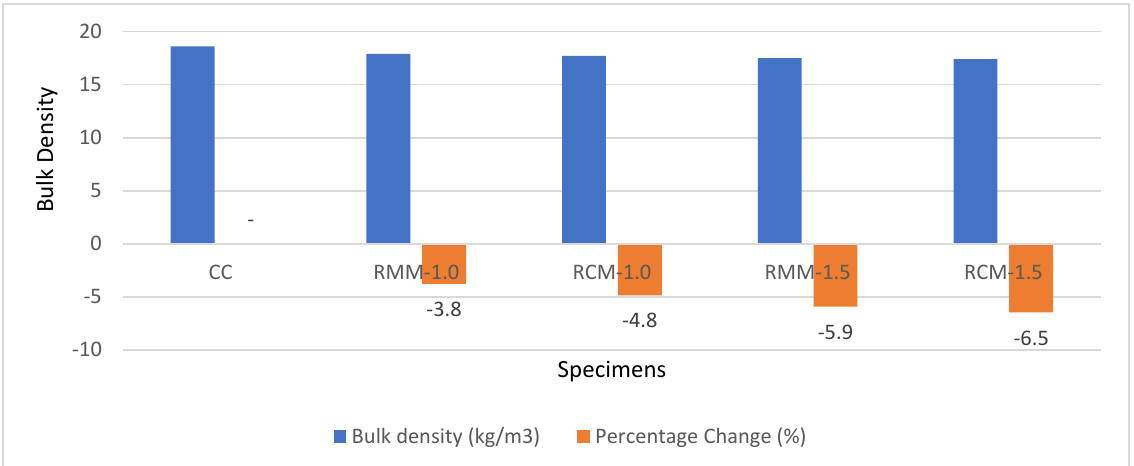
Figure 7. Chart showing the bulk density results.